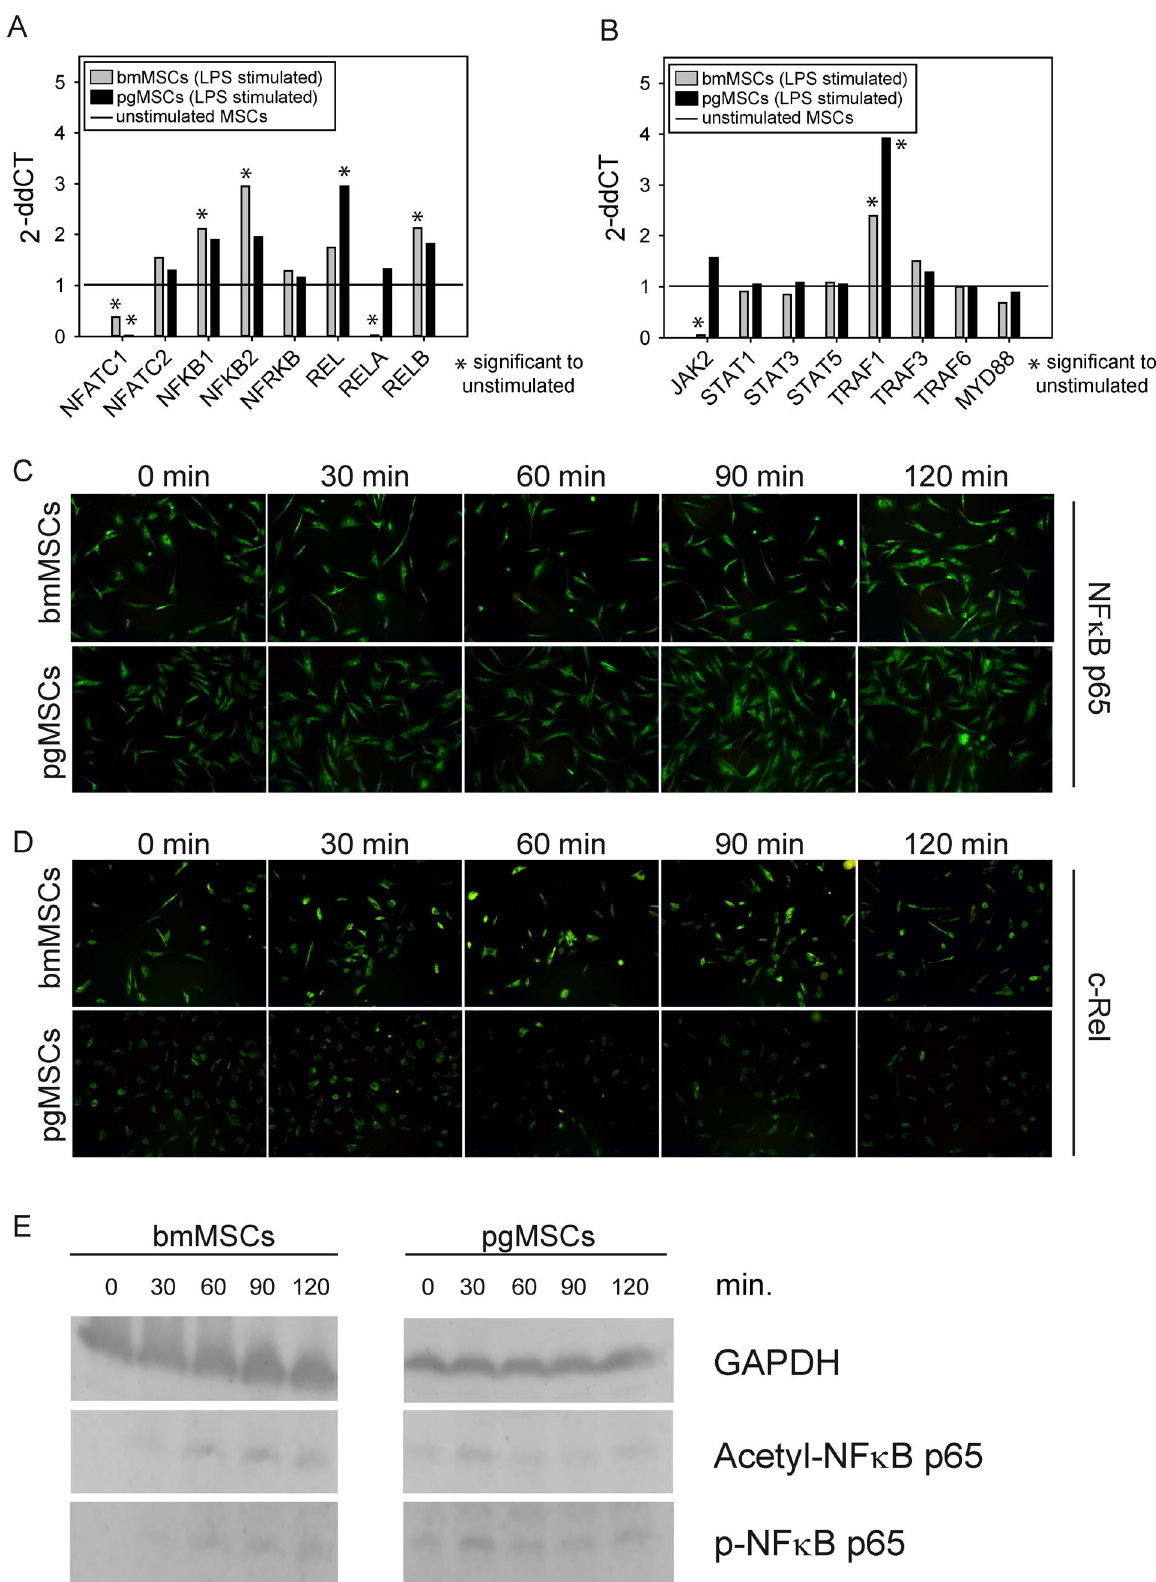
Figure 4. Activation of the NF- k B, JAK-STAT and TRAF pathways. (A/B) mRNA expression of bmMSCs and pgMSCs was determined in unstimulated and stimulated (LPS, 10 ng/mL for 4 h) MSCs by qPCR. mRNA was pooled from 4 different donors respectively for bmMSCs and pgMSCs. Gene expression of unstimulated MSCs wassetas 1 (referencevalue). Values $ 2.0aresetas a significantincrease of geneexpression andvalues # 0.5 are